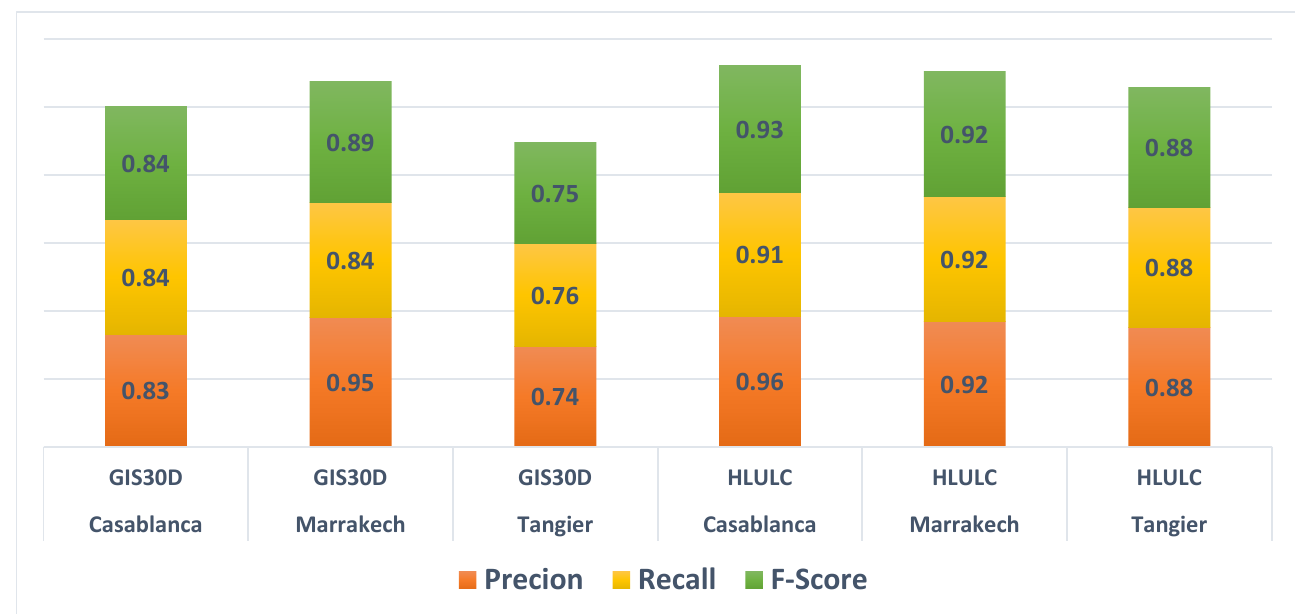
Figure 5. Statistical metrics using Precision, recall, and F ‐ score between HLULC and GIS30D .